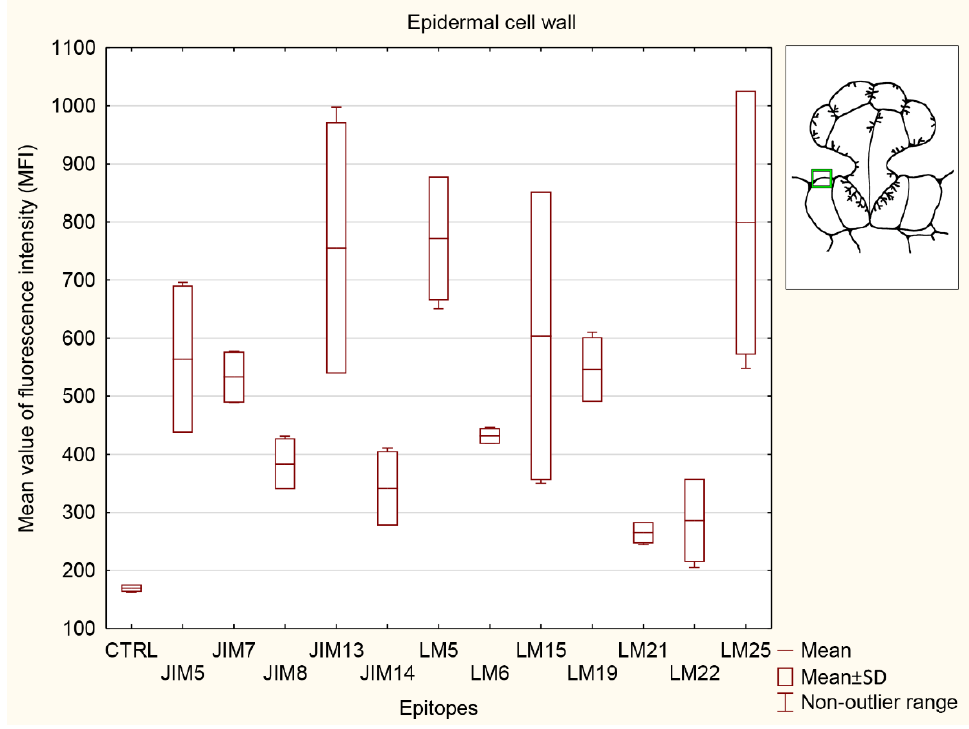
Figure 8. Quantification of immunofluorescence labeling for the ordinary epidermal cell wall. Mean values of AGP fluorescence intensity (MFI) for negative control reaction (CTRL) and for labeled AGPs (JIM14, JIM8, and JIM13 epitopes), pectins (JIM5, JIM7, LM5, LM6, and LM19 epitopes), hemicelluloses (LM 15 and LM25 epitopes), and heteromannans (LM21 and LM22 epitopes) in 3 glands from 3 different traps (n = 3).